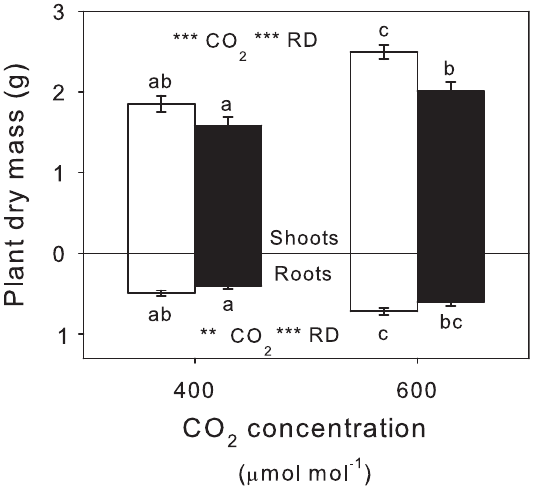
Figure 2. Plant biomass (dry) as affected by root damage and CO 2 . Shoot and root mass of plants at aCO 2 and eCO 2 without (open bars) and with (closed bars) root damage (RD). Mean values 6 S.E. shown, N = 24. Statistical significance of treatments indicated **( P , 0.01) and *** ( P , 0.001) with lowercase superscript letters indicating significant differences ( P , 0.05) between treatments.